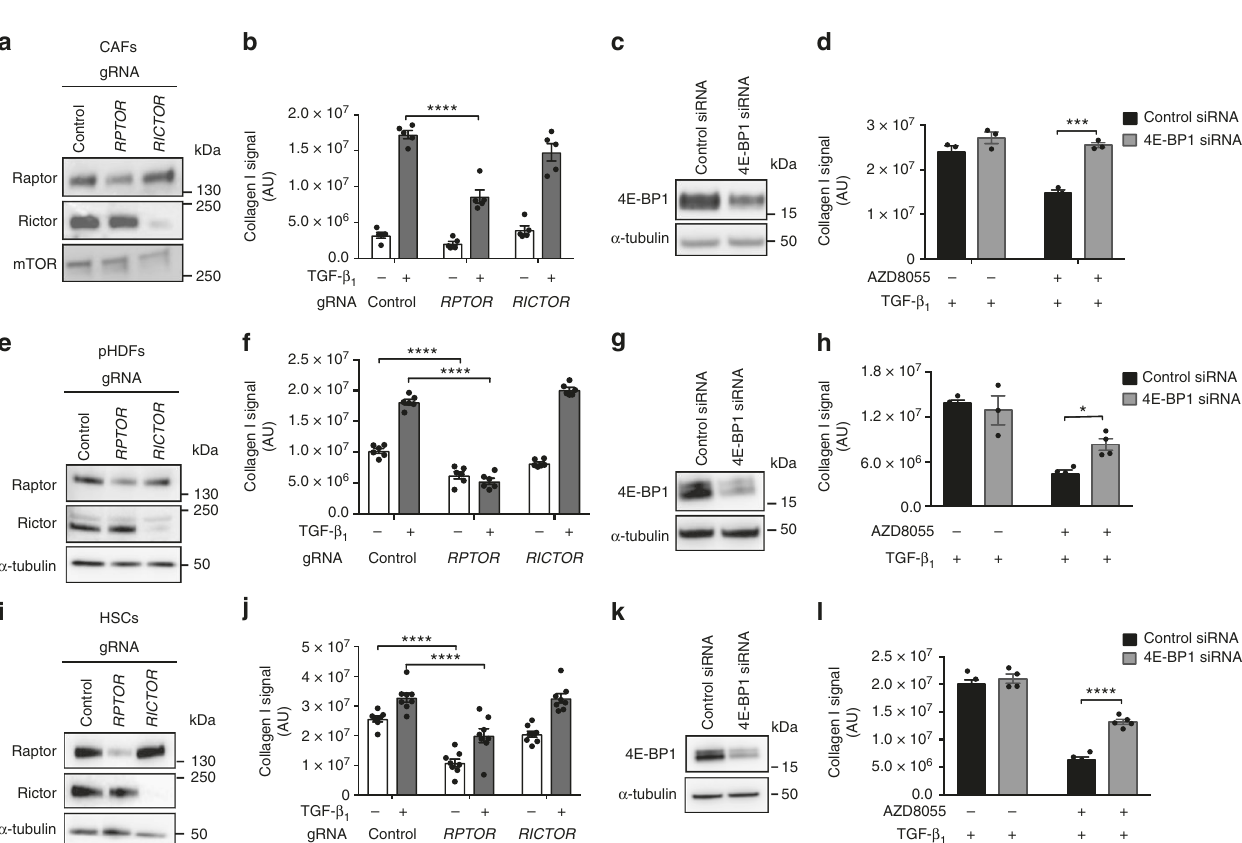
(Nordic Bioscience). Figure 8c shows that P1NP levels in slice supernatants were reduced in the presence of CZ415 in a concentration-dependent manner. This observation was con- fi rmed in tissue slices obtained from 5 additional IPF donors (Supplementary Table 5). To con fi rm target engagement of the mTORC1/4E-BP1 axis, 4E-BP1 phosphorylation was measured in